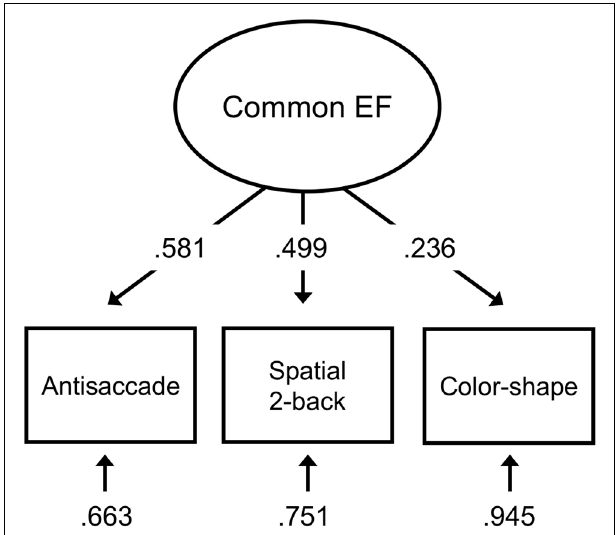
FIGURE 2 | EF measurement model with antisaccade accuracy, spatial 2-back accuracy, and color-shape reaction time switch cost representing inhibition, updating, and shifting abilities, respectively. Standardized estimates